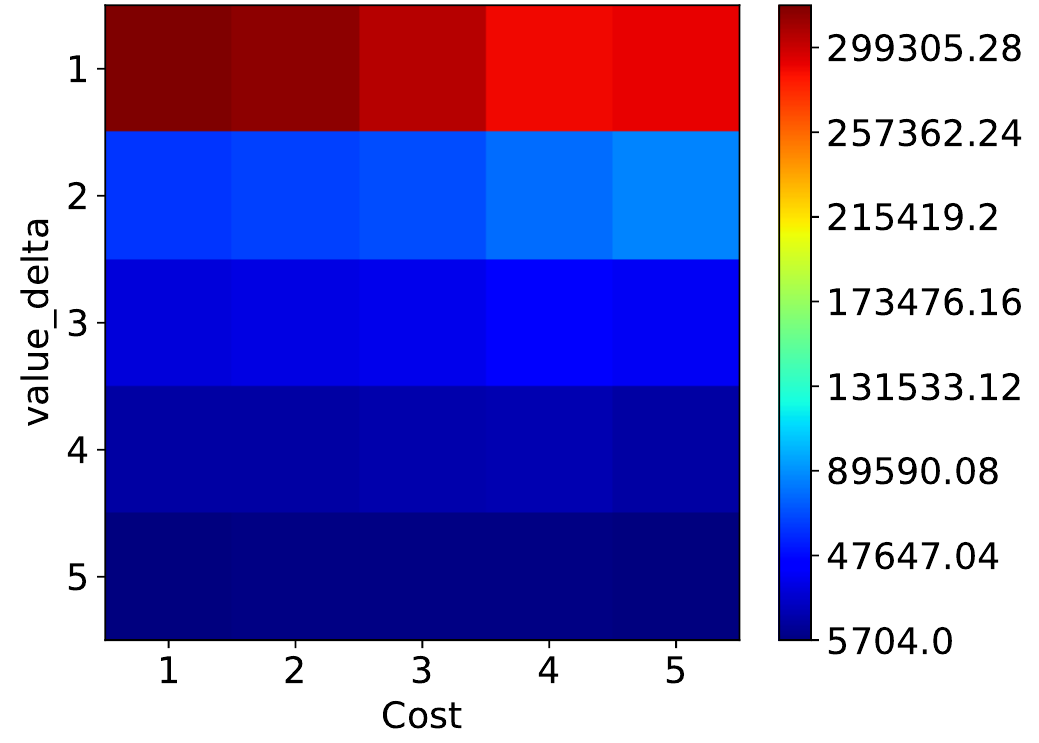
Figure A3. Average frequency of value/cost combinations in the NREL dataset. Data points with a combination of low value and high cost are more frequent in the dataset than data points with high value and high cost. Values are normalized by the maximum speed of the trip and binarized in N integer